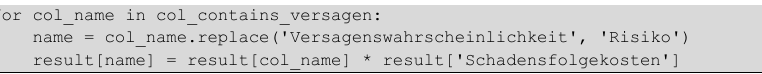
Figure 3. Python programming (Jupyter